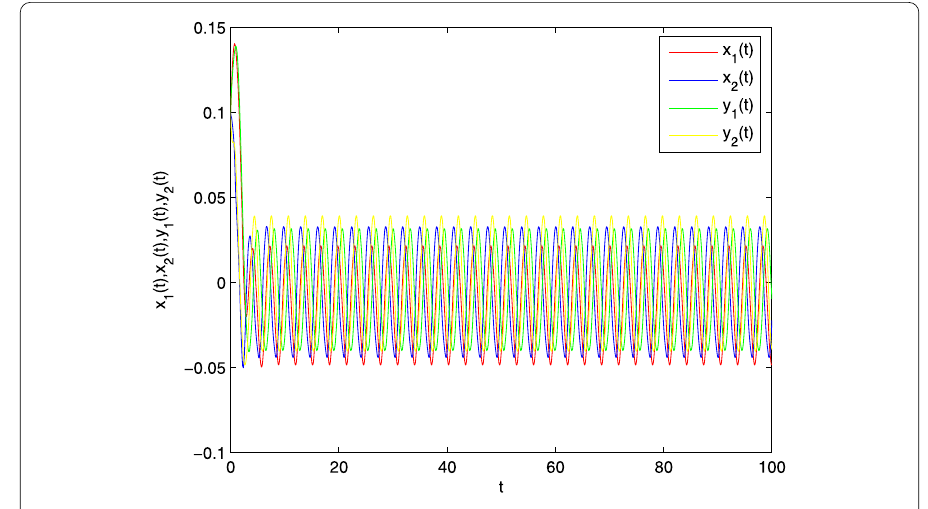
Figure 1 Transient response of state variables x 1 ( t ), x 2 ( t ), y 1 ( t ), and y 2 ( t